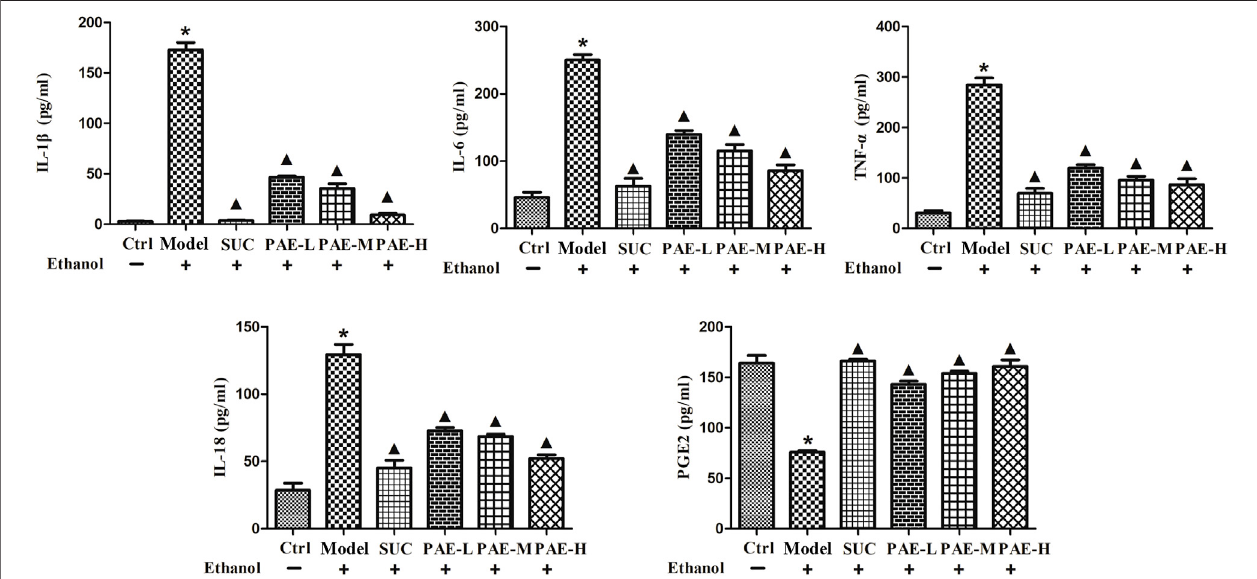
FIGURE 6 | Effect of PAE on the levels of in fl ammatory cytokines, i.e., IL-1 β , IL-6, TNF- α , IL-18, and PGE2, in ethanol-stimulated gastric tissues. * p < 0.05, Ctrl group vs. Gastric ulcer model group; ▲ p < 0.05, PAE/SUC treatment group vs. Gastric ulcer model group.